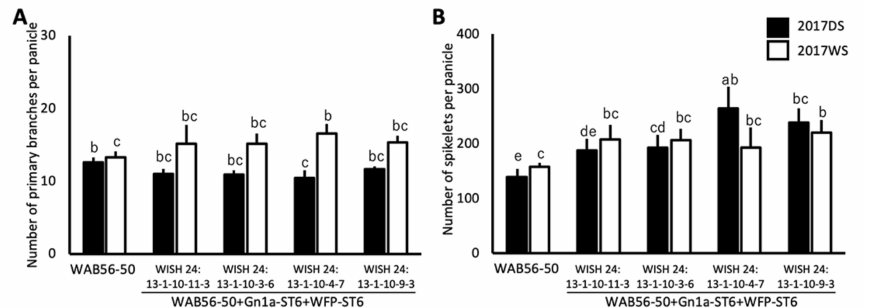
Figure 8. Number of primary panicle branches ( A ) and number of spikelets per panicle ( B ) (mean ± SD) of stacked introgression lines of Gn1a - ST6 and WFP - ST6 in the genetic background of WAB56-50. Solid and white bars show the results in 2017DS and 2017WS, respectively. Different letters above the bar graphs indicate significant difference at p <